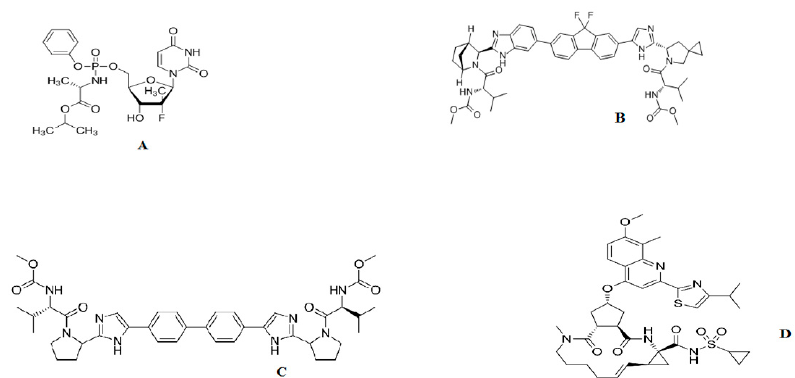
Figure 1. Chemical structures of ( A ) sofosbuvir, ( B ) ledipasvir, ( C ) daclatasvir, and ( D ) simeprevir. LD (molecular weight = 889.01 g/mol) has pKa value pKa 1 = 11.33 and is a novel HCV NS5A inhibitor that has shown potent antiviral activity (Figure 1B). LD affects the HCV NS5A protein, which is involved in both RNA replication and aggregation of HCV virions [7]. A fixed-dose genotype 1HCV [8].